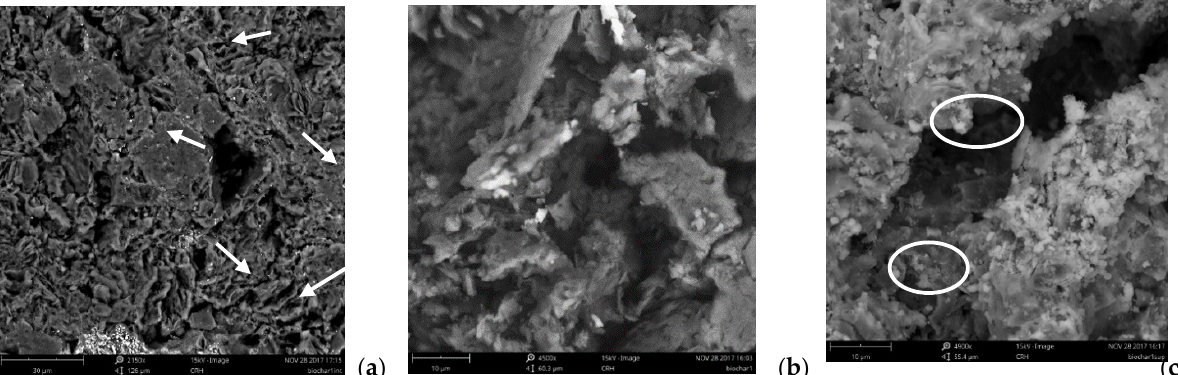
Figure 3. Graphite-like structures (white arrows) in biochar section at 2150× ( a ), 4500× ( b ). ( c ) Examples of nanophase particles are highlighted by the circles (4900×).